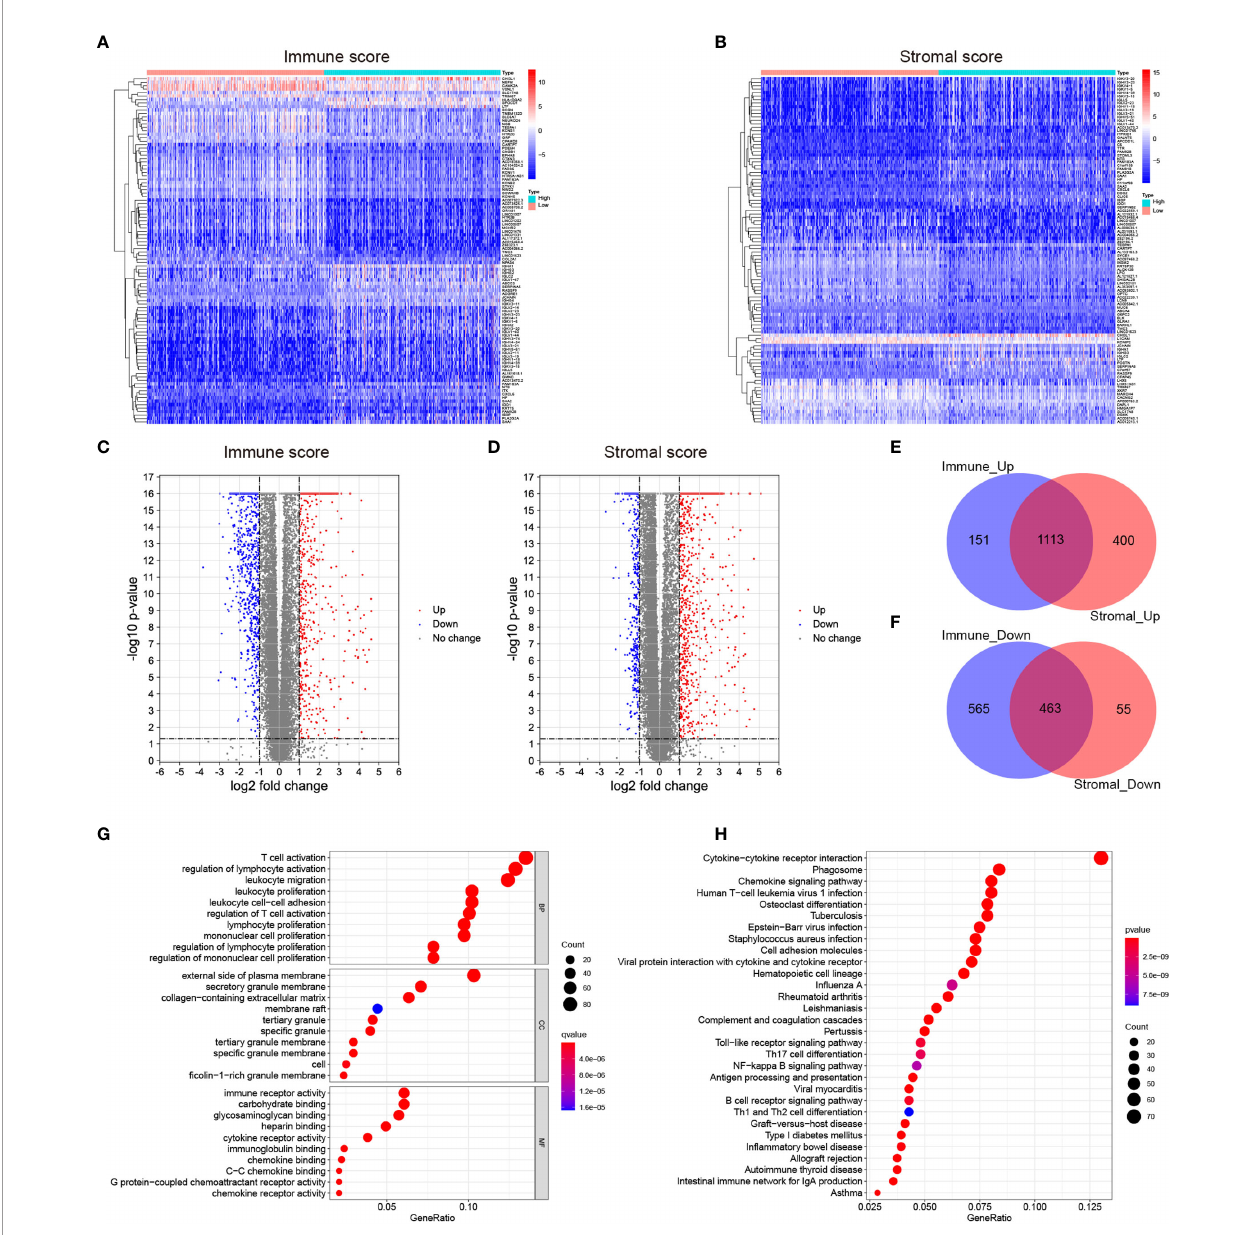
FIGURE 2 | Identi fi cation of the differentially expressed genes (DEGs) based on the immune and stromal scores of the LGGs. (A, B) Heatmaps showing the distribution patterns of differentially expressed genes based on immune and stromal scores. The darker the red color, the higher the gene expression was. The deeper the blue color, the lower the gene expression was. (C, D) Volcano plots of signi fi cantly differentially expressed genes based on immune and stromal scores (|lg FC|>1, p < 0.05). Blue dots represented signi fi cantly down-regulated genes, and red dots represented signi fi cantly up-regulated genes. (E, F) Venn plots showing the overlapping DEGs between immune and stromal groups. (G) Bubble plot of GO enrichment analysis of DEGs. (H) Bubble plot of KEGG enrichment analysis of DEGs. Node size represented the number of DEGs contained in the corresponding GO/KEGG term, and the node color denoted the p-value. P-value<0.05 was considered statistically signi fi